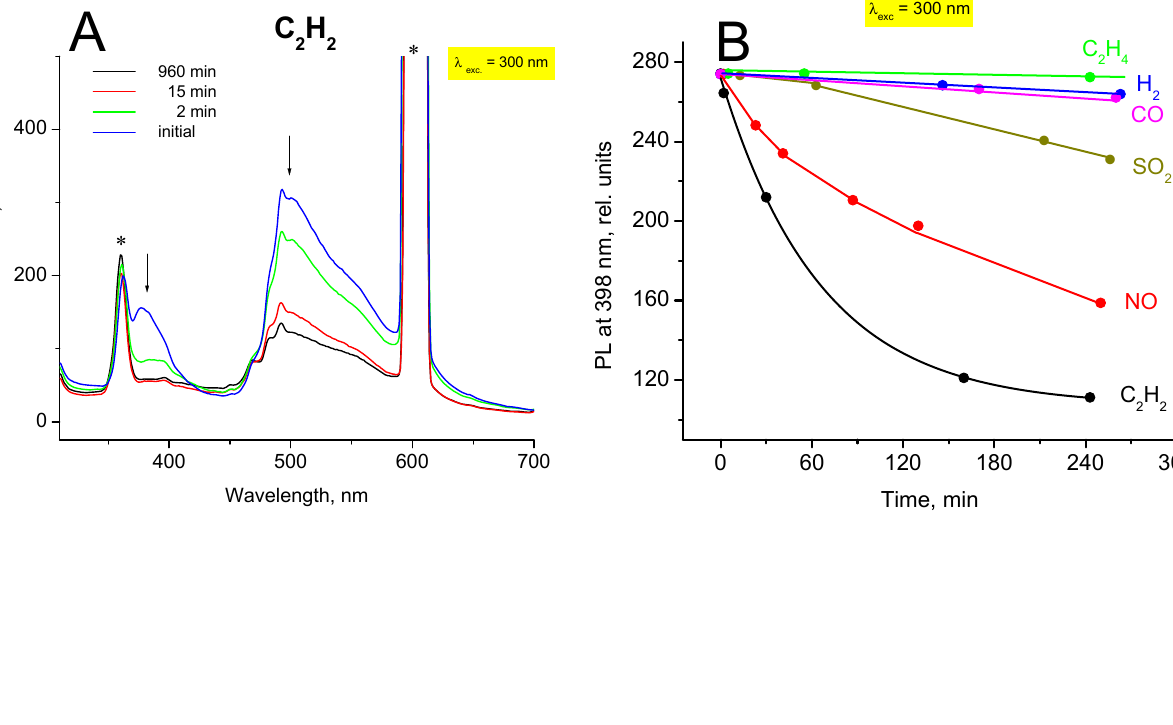
Figure 21. Changes in emission of solid sample of Ag(CCO) with time in the presence of acetylene ( A ), and time profile of photoluminescence of Ag(ACO) in presence of several gases of industrial importance ( B ). Asterisks indicate instrumental